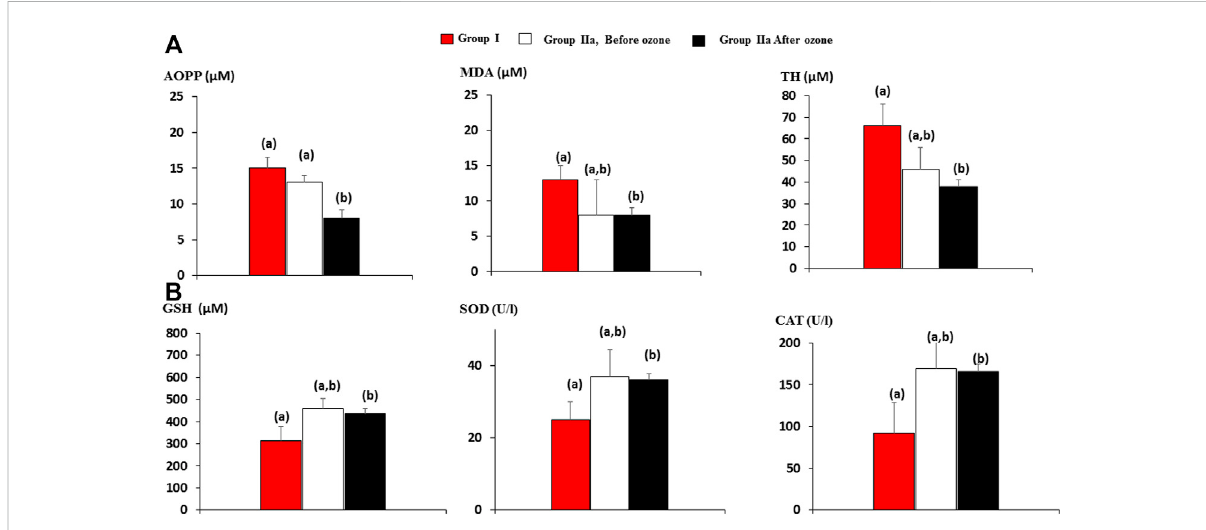
FIGURE 2 Injury and antioxidant defense biomarkers in older patients (60 – 70 years old) with rheumatoid arthritis + comorbidities in group I (n = 15) and group IIa, rheumatoid arthritis + comorbidities, n = 15, treated with medical ozone + methotrexate + ibuprofen + folic acid. Group I, the same as IIa, but without medical ozone. (A) Injury markers, AOPP, advanced oxidation protein product; MDA, malondialdehyde; TH, total hydroperoxide; (B) antioxidant defense markers, GSH, reduced glutathione; SOD, superoxide dismutase activity; CAT, catalase activity. The data re fl ecting AOPP, MDA, TH, GSH levels, SOD, and CAT activities are the mean ± S.E.M. of each group. Mean values with different letters indicate signi fi cant differences ( p < 0.05) between groups.